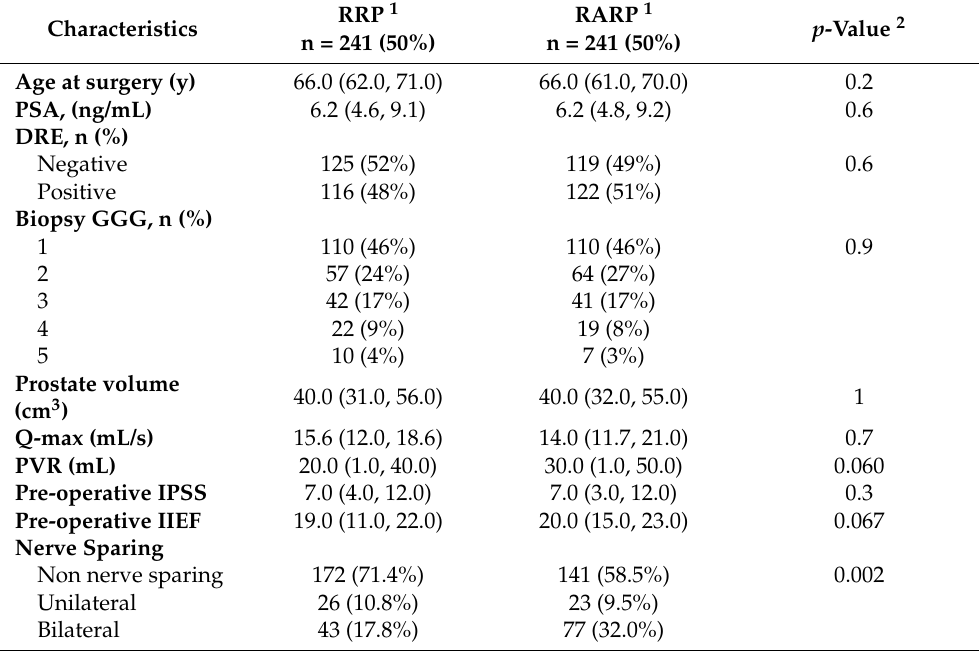
Table 1. Preoperative characteristics of the study population after propensity matching.